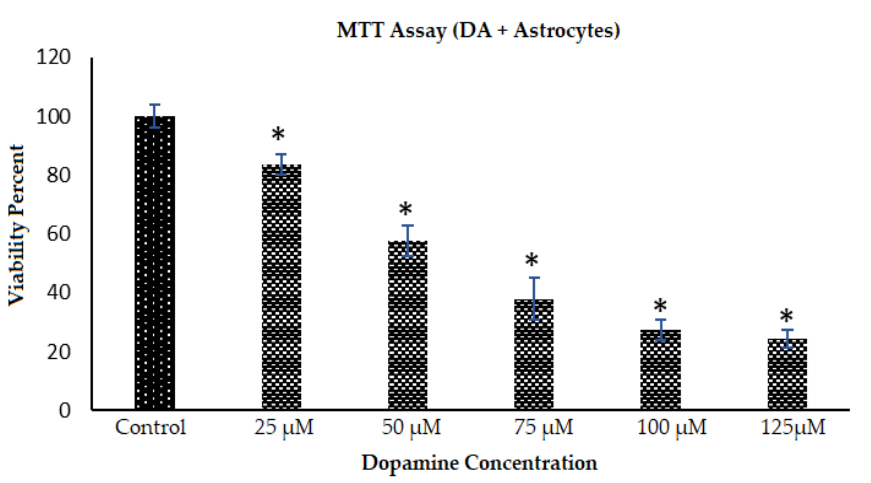
Figure 8. Metabolic activity/viability analysis of astrocytes in the presence of PDA per different DA concentrations. DA was introduced in astrocyte media in the above indicated concentrations. After 48 h in the incubator, astrocytes were plated at 5000 cells/well and allowed to grow for 3 days in the already formed PDA environment. A MTT assay was carried out to measure the cellular metabolic activity in the presence of PDA. Data come from multiple platings of each of the six conditions (bars in the figure), and * denotes p < 0.05 compared to the control condition.